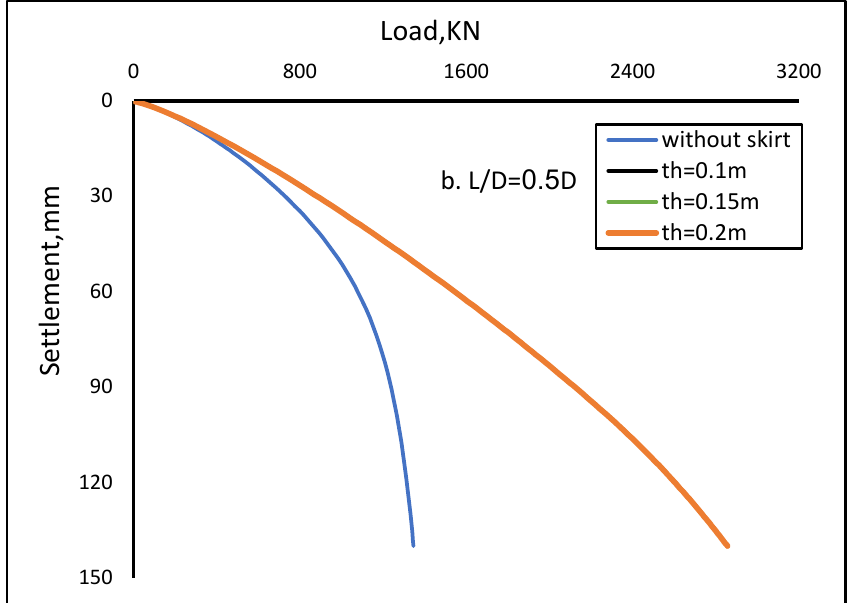
Fig. 4. Load-settlement relationship for skirt circular footing L/D=0.25.